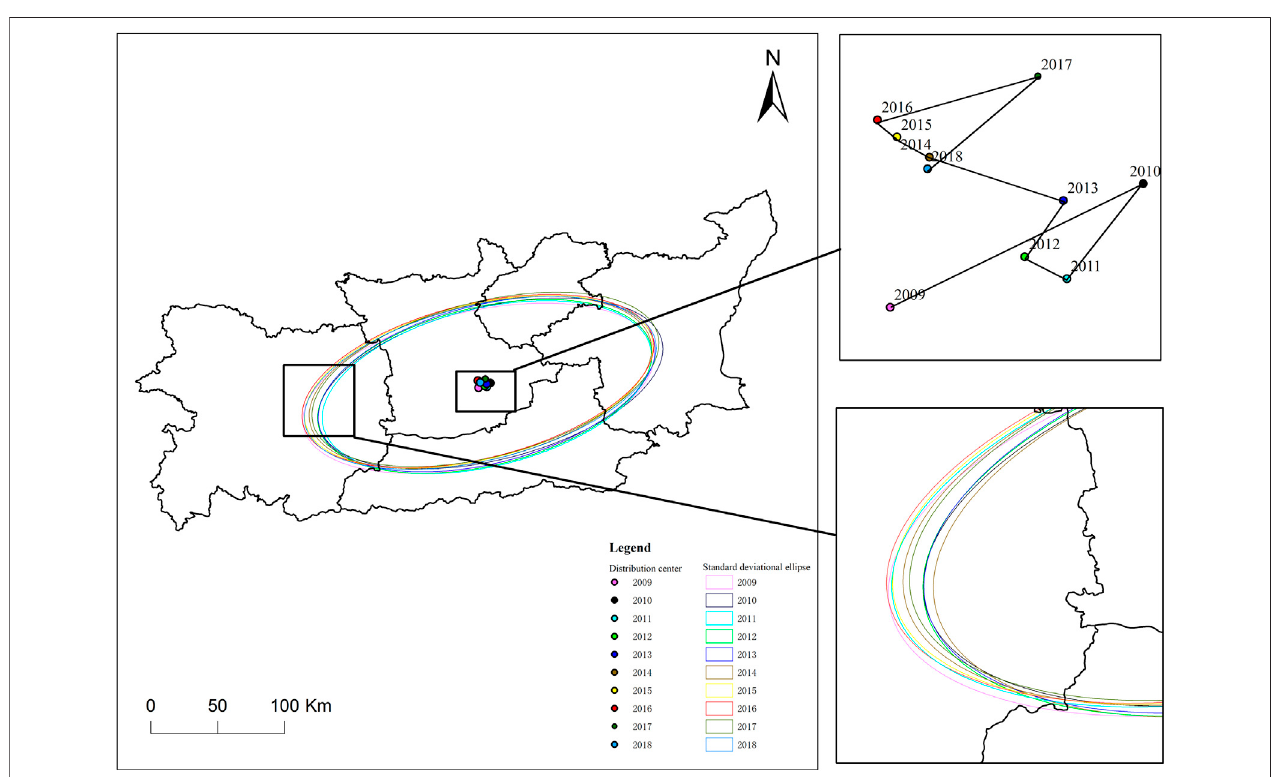
FIGURE 4 | The evolution of a spatial distribution pattern on the river basin sustainable development. D 1 – D 31 represent the obstacle degree of the corresponding indicator.